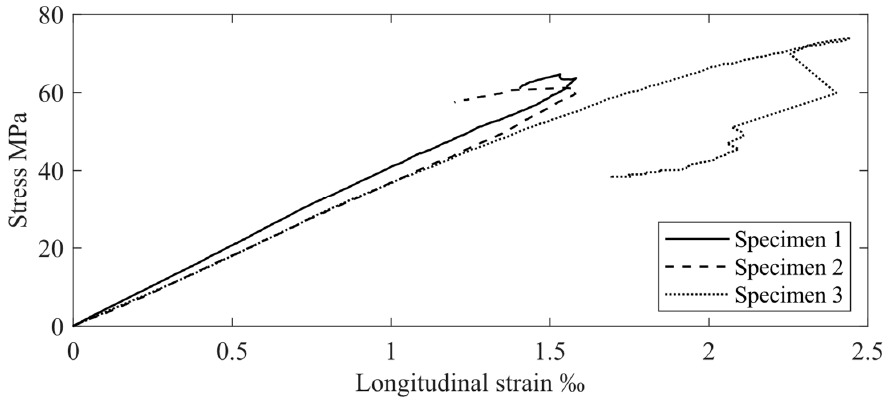
Figure 13. Experimental σ c – ε c dependences for HSC (following [6]). Figure 13. Experimental 𝜎 (cid:3030) – 𝜀 (cid:3030) dependences for HSC (following [6]). Figure 13. Experimental 𝜎 (cid:3030) – 𝜀 (cid:3030) dependences for HSC (following [6]).